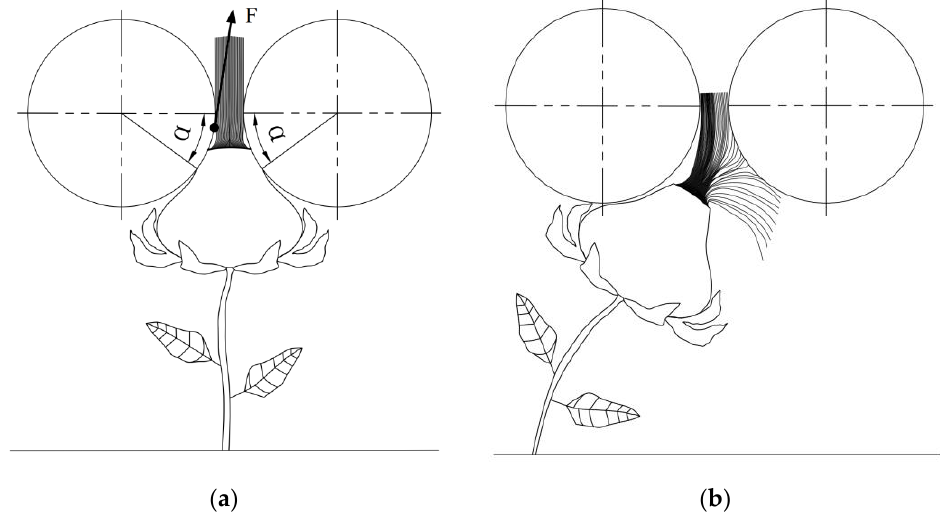
Figure 2. Effectiveness of picking safflower by dual rollers type end-effector: ( a ) Working principle diagram; ( b ) Effectiveness of picking tilting safflowers.